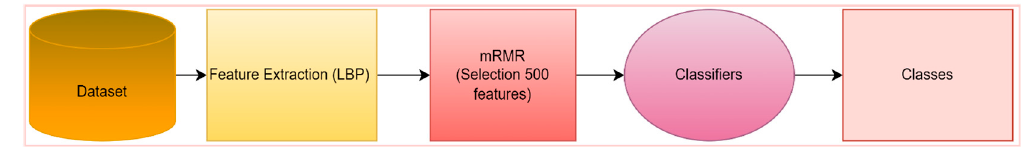
Figure 8. LBP—mRMR Flowchart.